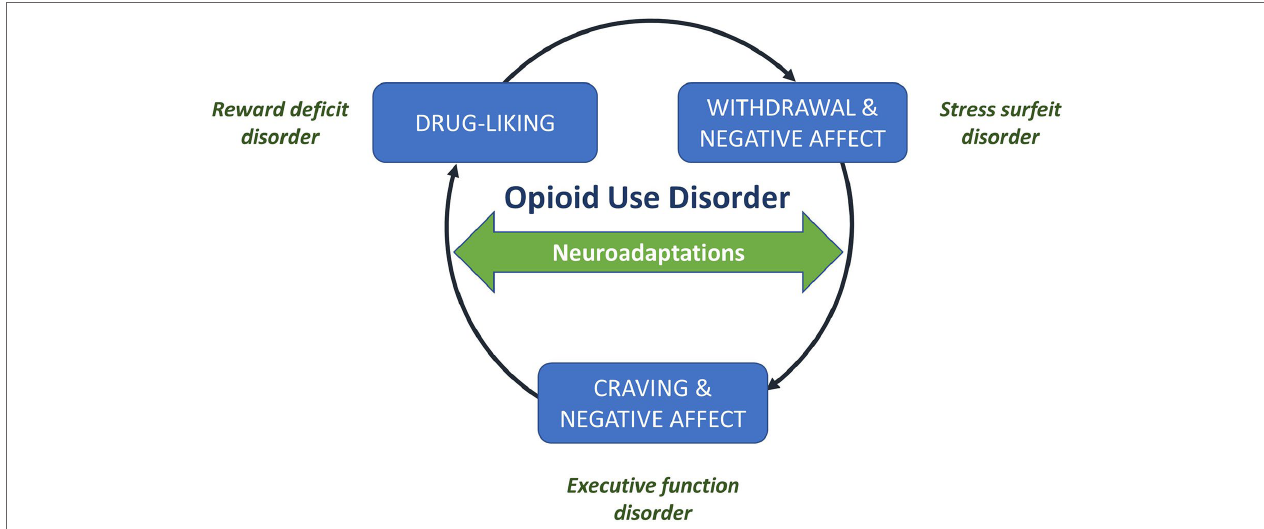
FIGURE 1 | Drivers in the cycle of addiction. The addiction cycle involves three key drivers: (1) pleasurable drug-liking (associated with euphoria in the early stages of addiction), (2) withdrawal and negative affect (the stress and dysphoria associated with withdrawal from a drug), and (3) craving for the drug and ongoing negative affect. Underlying these key drivers are neuroadaptations associated with reward deficit, stress surfeit, and executive function disorders, respectively. Figure reproduced and adapted under the CC-BY license from the ACH Servier Research Group